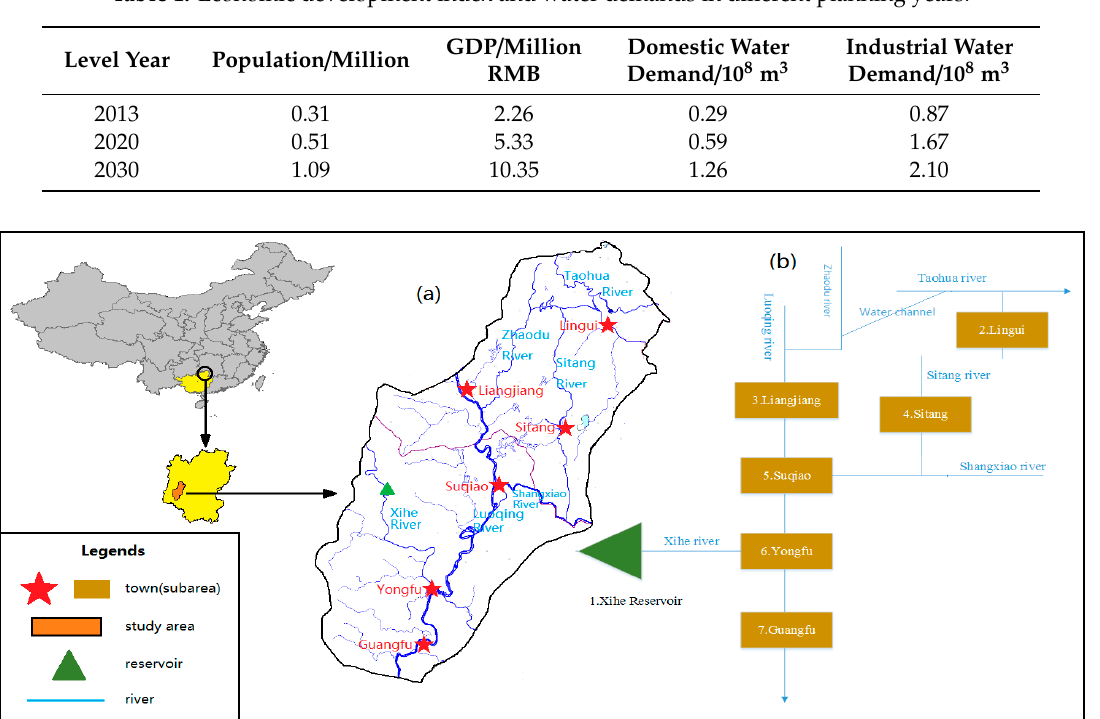
Figure 4. Location and water resources condition of the study area. ( a ) Actual river system and sub- area ( b ) the topology structure of rivers and sub-areas. ( b ) the topology structure of rivers and